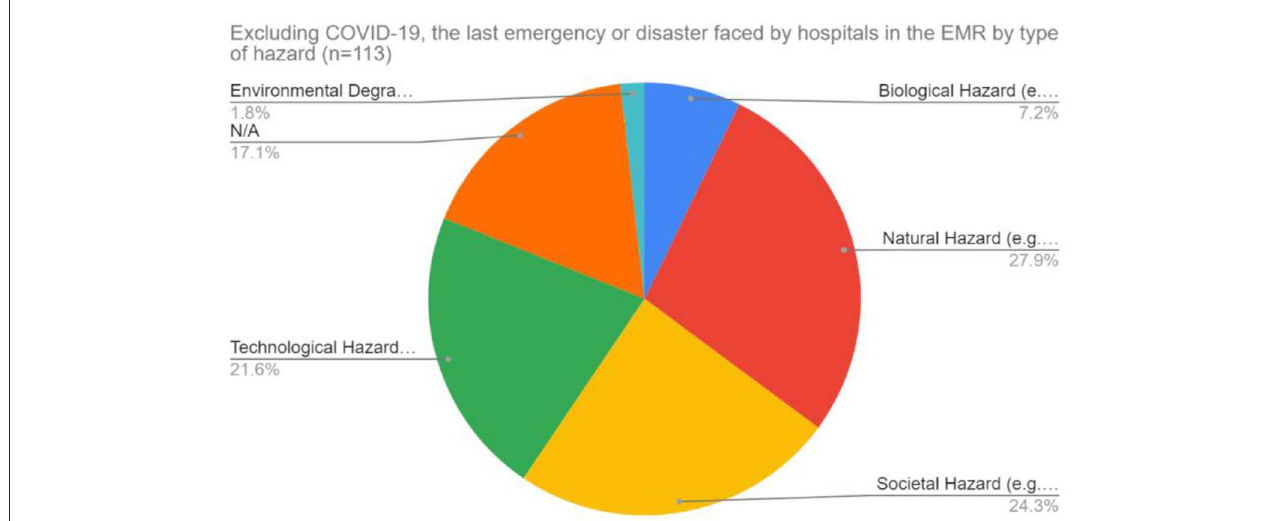
FIGURE5 Last type of emergency or hazard faced by hospitals in the EMR excluding COVID-19.